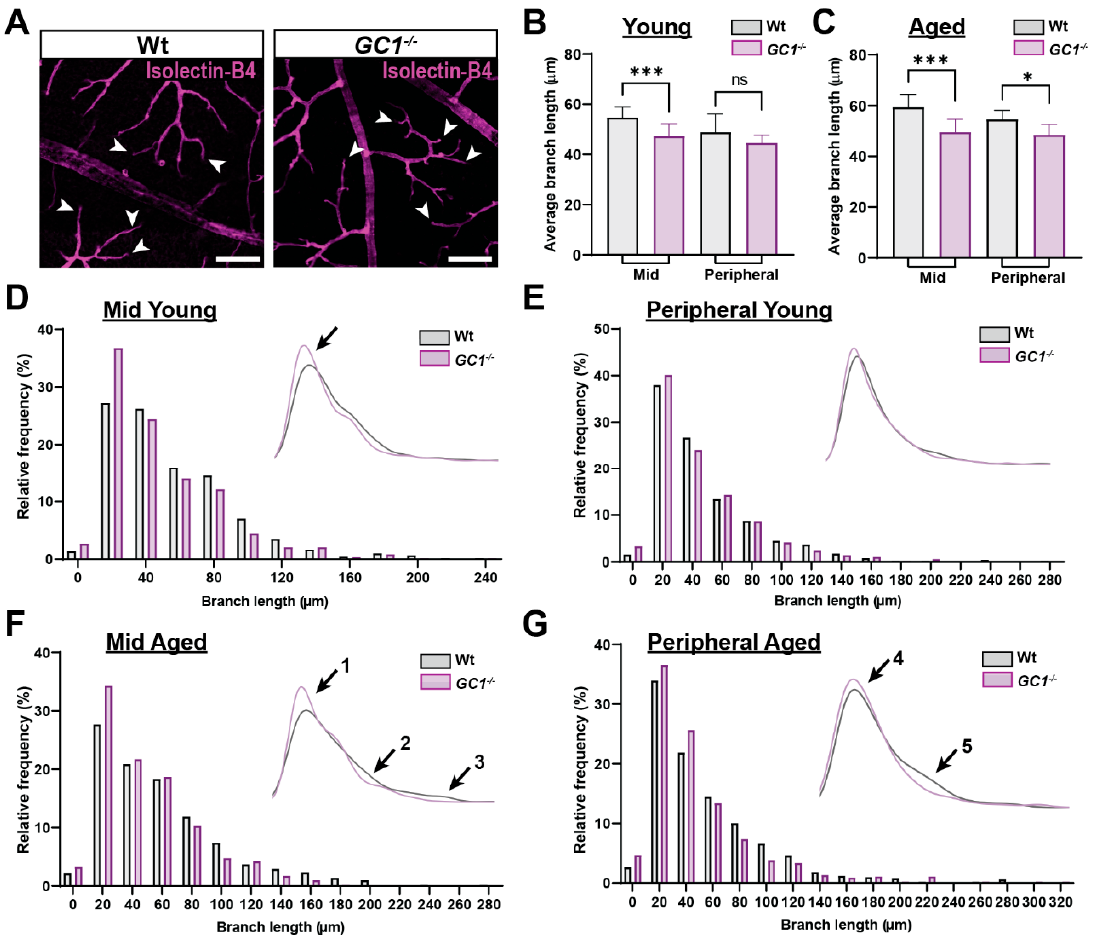
Figure 2. GC1 − / − mice have an increased frequency of shorter capillary branches compared to Wt mice. ( A ) Representative fluorescent images of Wt and GC1 − / − vessels stained with isolectin-B4. White arrows give example of a selection of terminal vessels, scale bar = 100 µm. ( B ) In mid retina of young mice, average branch length was significantly shorter in GC1 − / − mice compared with age- matched Wt mice. No significant difference was observed in the peripheral retina between geno- types ( n = 6 mice per genotype group; *** p = 0.0002 and p = 0.46). ( C ) In mid retina of aged mice, average branch length was significantly shorter in GC1 − / − mice compared with age-matched Wt mice ( n = 3 mice per genotype group; *** p = 0.0051). Average branch length in the peripheral retina of aged GC1 − / − mice was significantly shorter than in aged Wt mice ( n = 3 mice per genotype group; * p = 0.022). ( D ) Histogram showing normalized frequency of branch lengths in the mid retina of young Wt and GC1 − / − mice; inset: Kernel density estimation (KDE) plot. ( E ) Histogram showing normalized frequency of branch lengths in the peripheral retina of young Wt and GC1 − / − mice; inset: KDE plot. ( F ) Histogram showing normalized frequency of branch lengths in the mid retina of aged Wt and GC1 − / − mice; inset: KDE plot. There is an increase in the frequency of shorter vessel lengths (arrow 1) and a decreased frequency of longer vessel lengths in GC1 − / − mice (arrows 2 and 3). ( G ) Histogram showing normalized frequency of branch lengths in the peripheral retina of aged Wt and GC1 − / − mice; inset: KDE plot. The frequency of shorter branch lengths was increased in GC1 − / − mice (arrow 4) compared with Wt and a lower frequency of longer branch lengths was observed in GC1 − / − mice (arrow 5). Data are presented as means ± S.D. Statistical analyses carried out were Kruskal–Wallis one-way ANOVA.